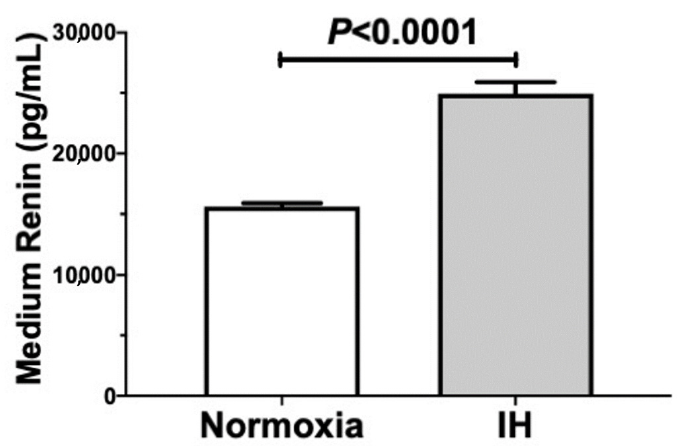
Figure 3. Concentrations of Ren in the As4.1 cell culture medium. The As4.1 cells were subjected to normoxia or IH conditions for 24 h. The medium Ren concentrations were measured by means of an ELISA. The data are expressed as the mean ± SE for each group of six independent experiments (n = 6). The statistical analyses were performed using a Student’s t -test.